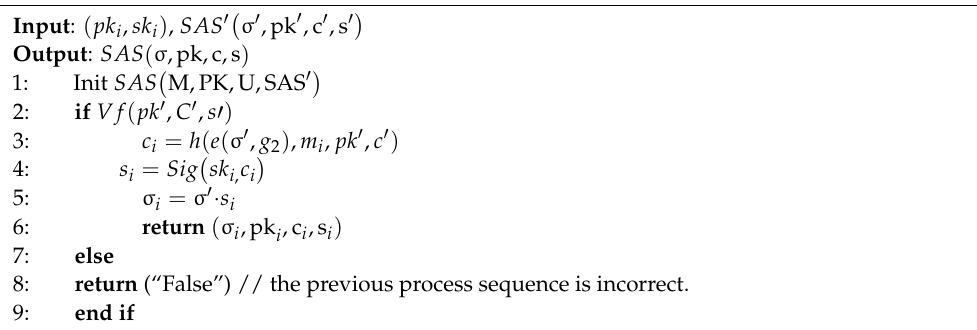
Algorithm 1: Validation algorithm for sequential execution of processes